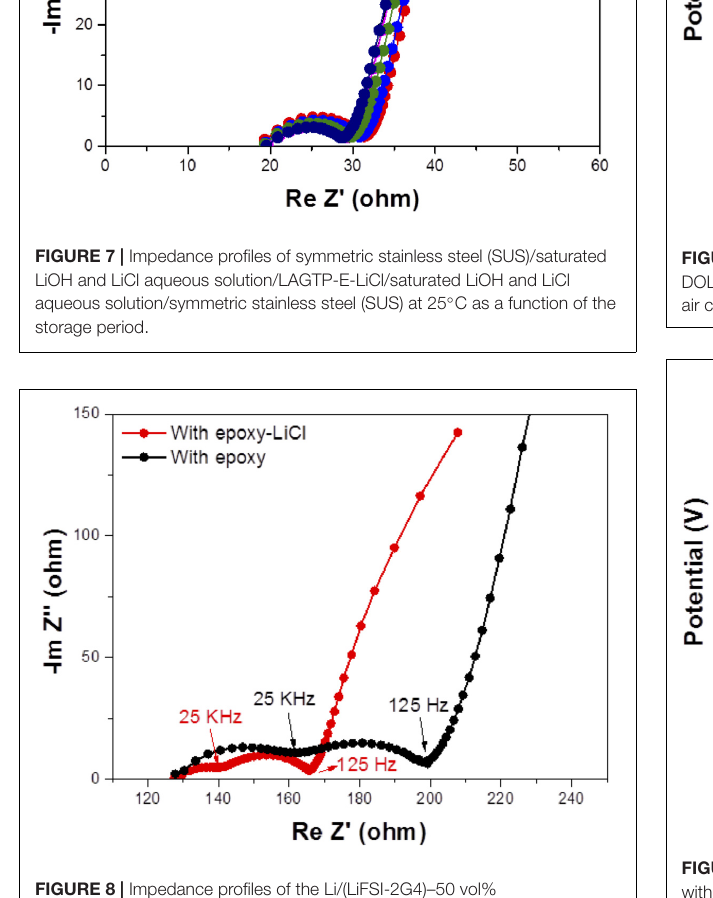
FIGURE 8 | Impedance profiles of the Li/(LiFSI-2G4)–50 vol% DOL/LAGTP-E-LiCl or LAGTP-E/saturated LiOH and LiCl aqueous solution/KB, air cells at 25 ◦ C.